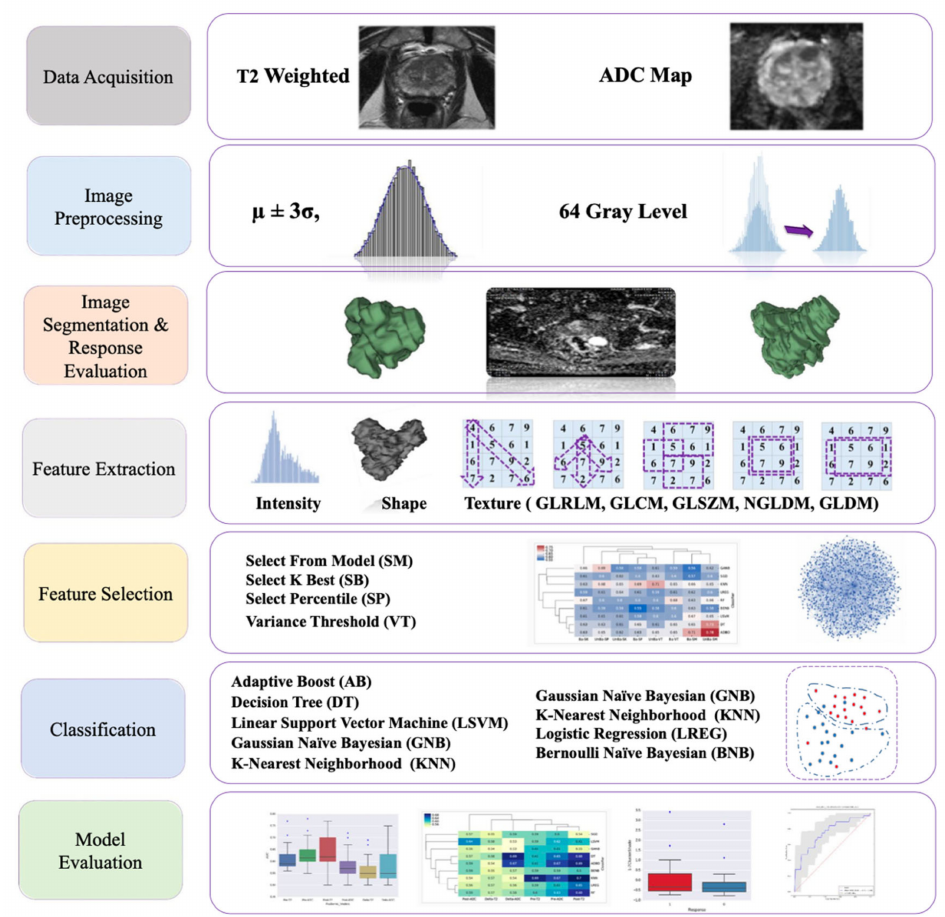
Figure 3. Sample radiomics workflow (reprinted with permission from [40], Copyright 2019 Springer